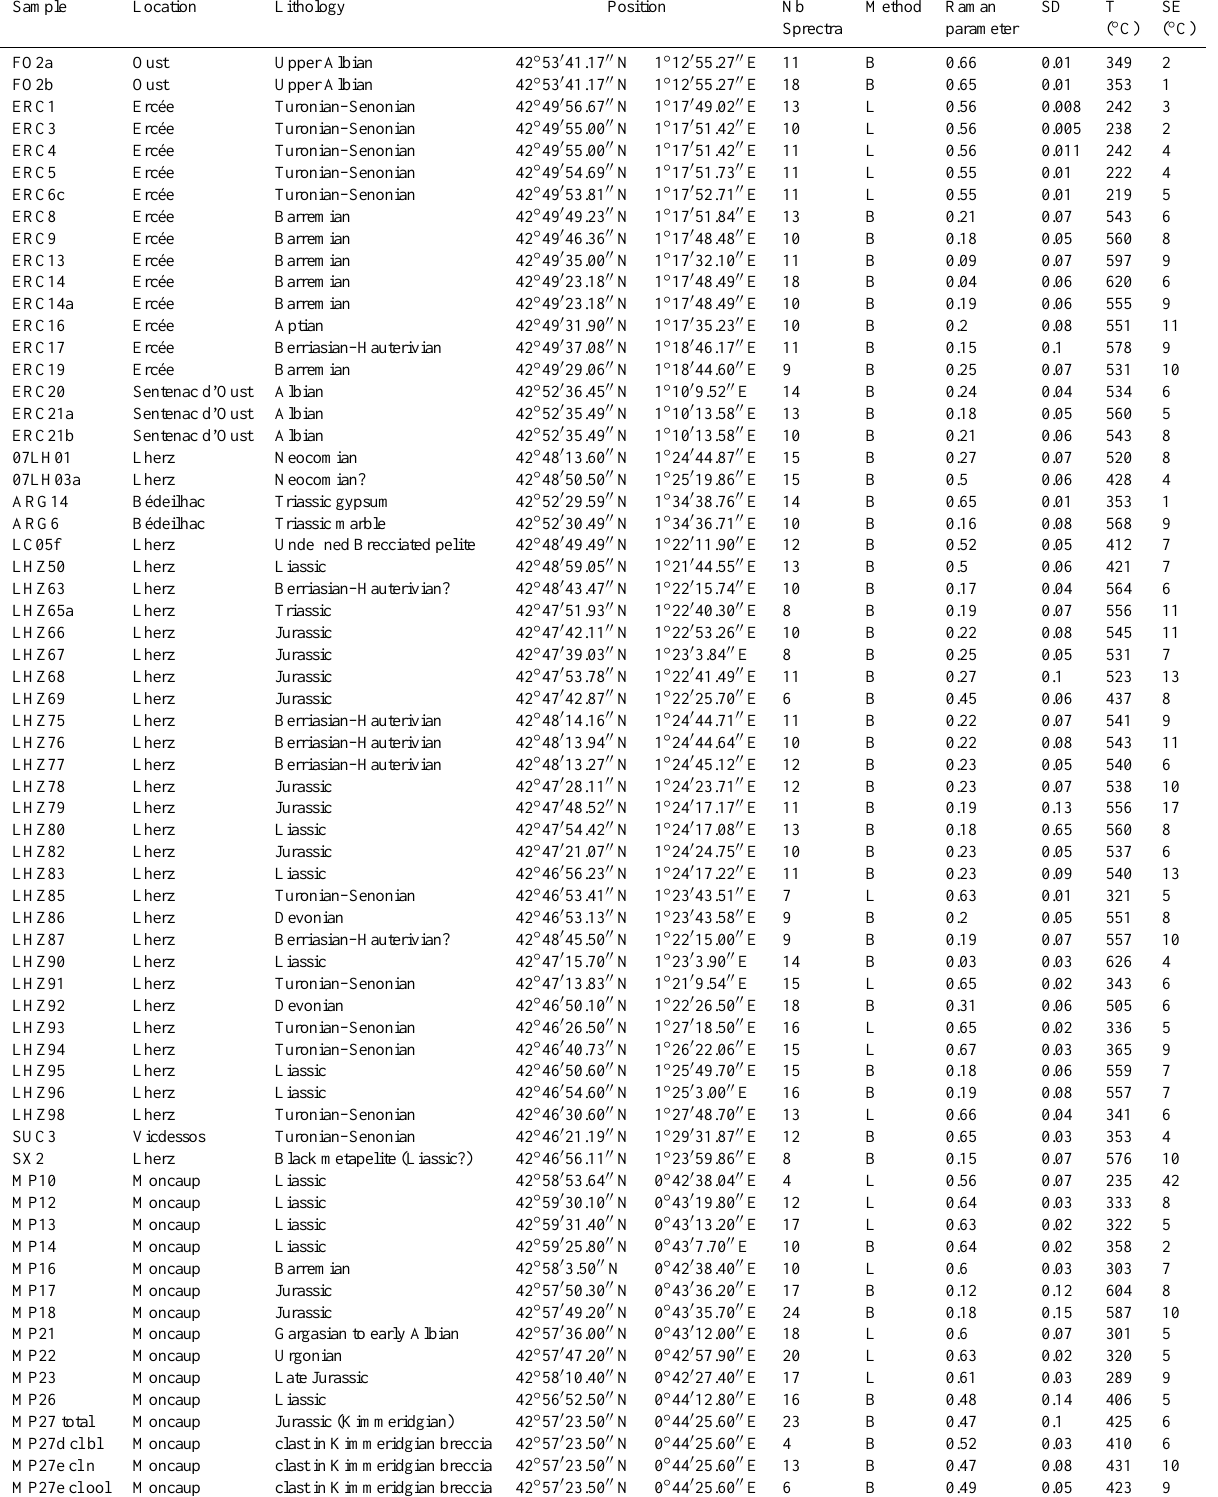
Table 1. RSCM peak temperatures from the NPZ. The parameters RA1 Lahfid (Lahfid et al., 2010) and R2 Beyssac (Beyssac et al., 2002) are used to estimate temperatures < 320 and > 330 ◦ C, respectively. RA1 Lahfid , R2 Beyssac and T are expressed in terms of mean value and SD of all the data obtained within each of the 106 samples from the NPZ sample. Standard errors ε are given for temperatures ( = 1 σ SD divided by the square root of the number of